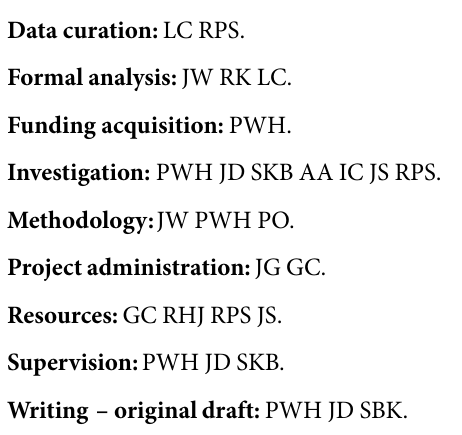
S1 Table. Treatment and clinical progression during